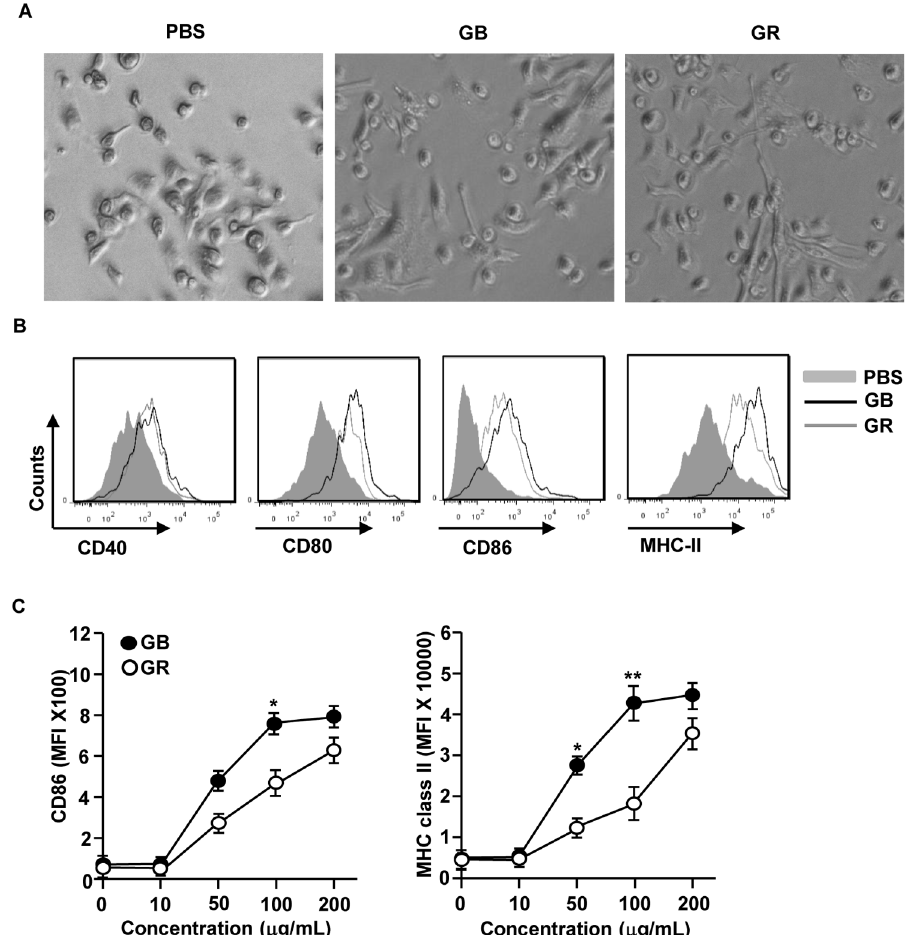
Fig 1. Activation of BMDC by GB. Bone marrow cells (1 X 10 6 ) were incubated with 50 ng/ml GM-CSF and 50 ng/ml IL-4 for 6 days, and then stimulated with GB or GR for 24 hours. (A) Morphological changes were analyzed by microscopy. (B) Expression of surface co-stimulatory molecules measured by flow cytometry. (C) CD86 and MHC class II expression levels were measured from GR- or GB-treated BMDC in indicated dose. All data are representative of or the average of analyses of 6 independent samples (2 samples per experiment, total 3 independent experiments). * p < 0 . 05 , ** p < 0 . 01